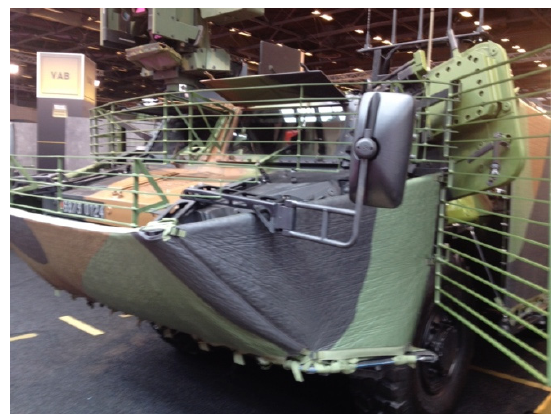
Figure 5. Bar armour system.